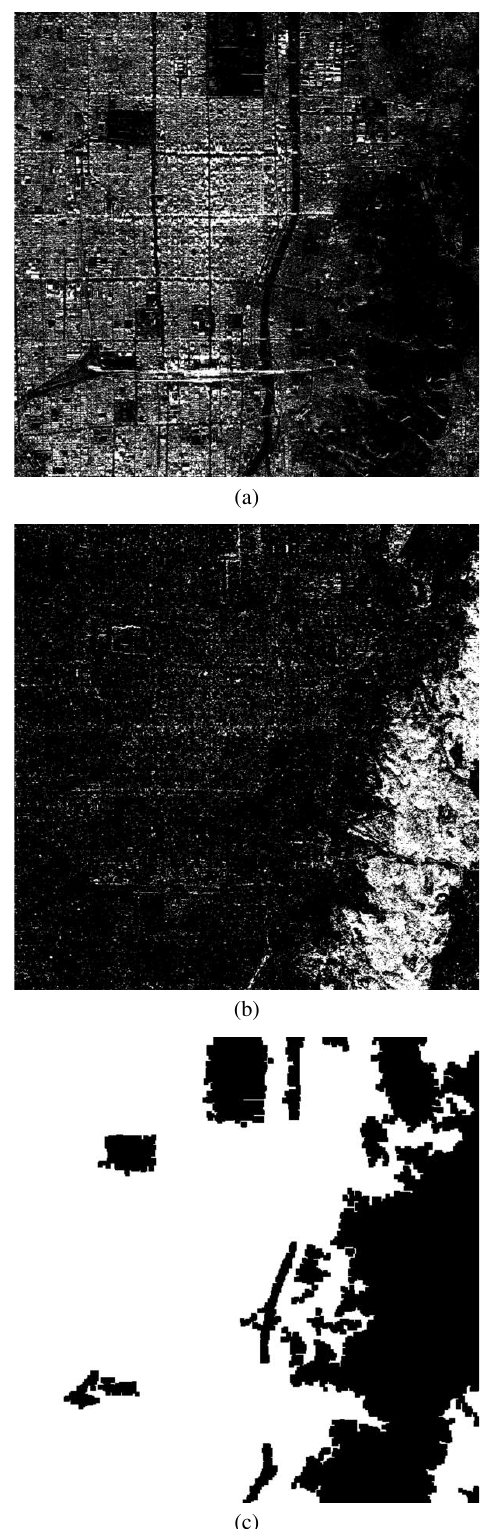
Figure 5. Urban areas in study area 1. (a) Urban candidate areas generated by intersection of Figures 3(b) and 4(b), (b) result gen- erated by filtering and closing (a), and (c) final result generated by labeling (b).